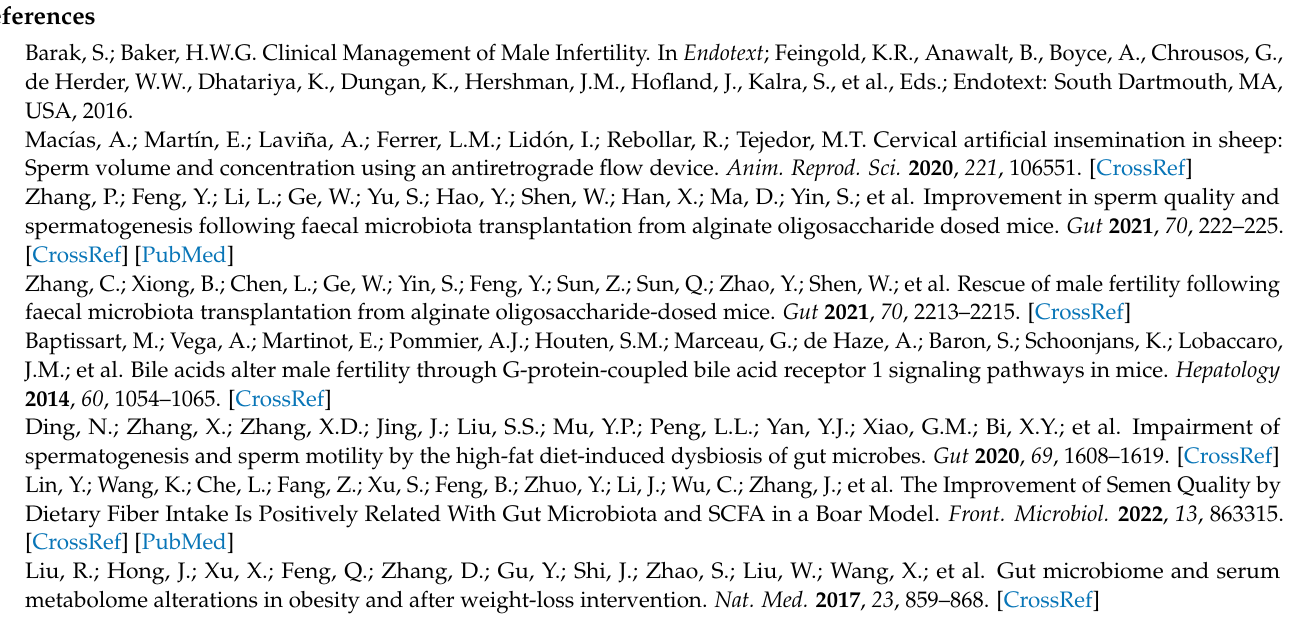
Figure S2: Serum and seminal plasma metabolomic profile in different groups, Figure S3: Multi- omics integrated analysis of DIABLO; Table S1: The motility parameters of sheep sperm were tested, Table S2: Significantly differentiated genera between the LM and HM groups, Table S3: Differential metabolites found in seminal plasma samples, Table S4: Differential metabolites found in serum samples, Table S5: Results of seminal plasma sample pathway analysis, Table S6: Results of serum sample pathway